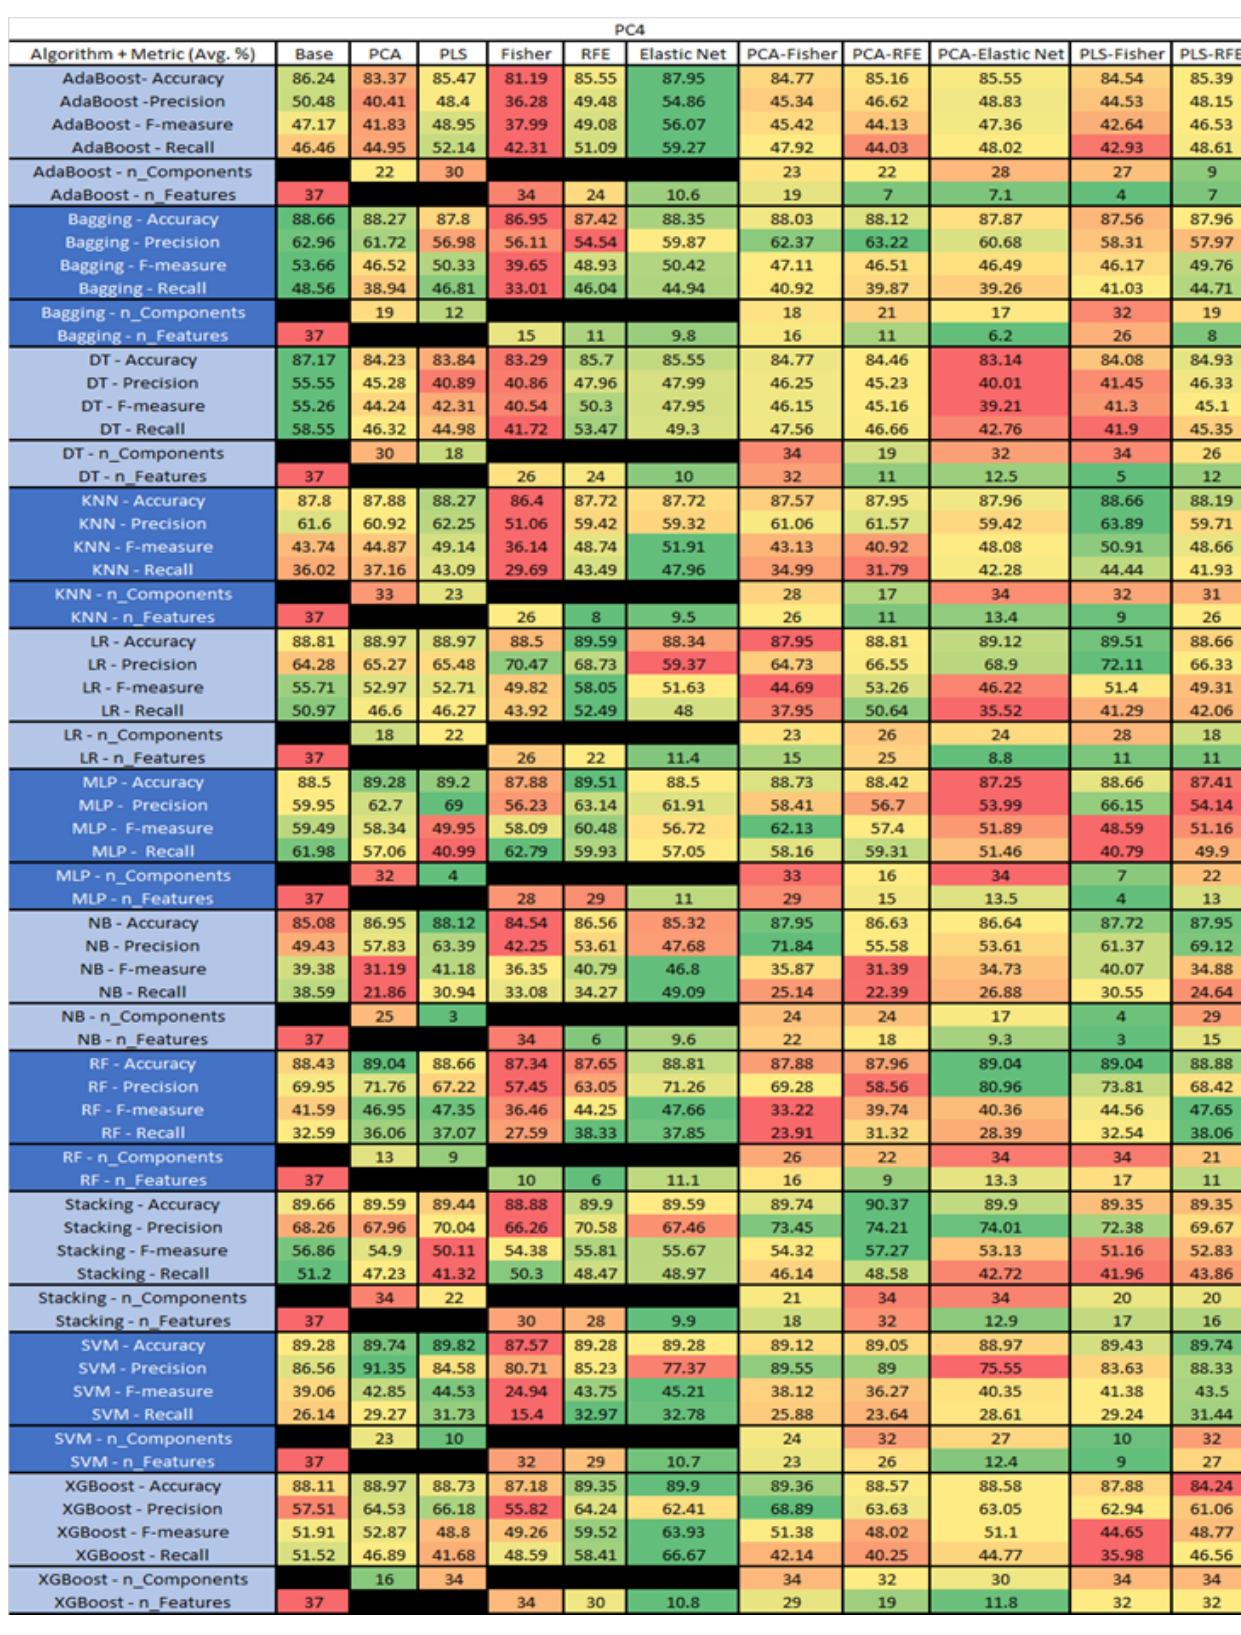
Figure 46. PC4 NASA MDP Results Data